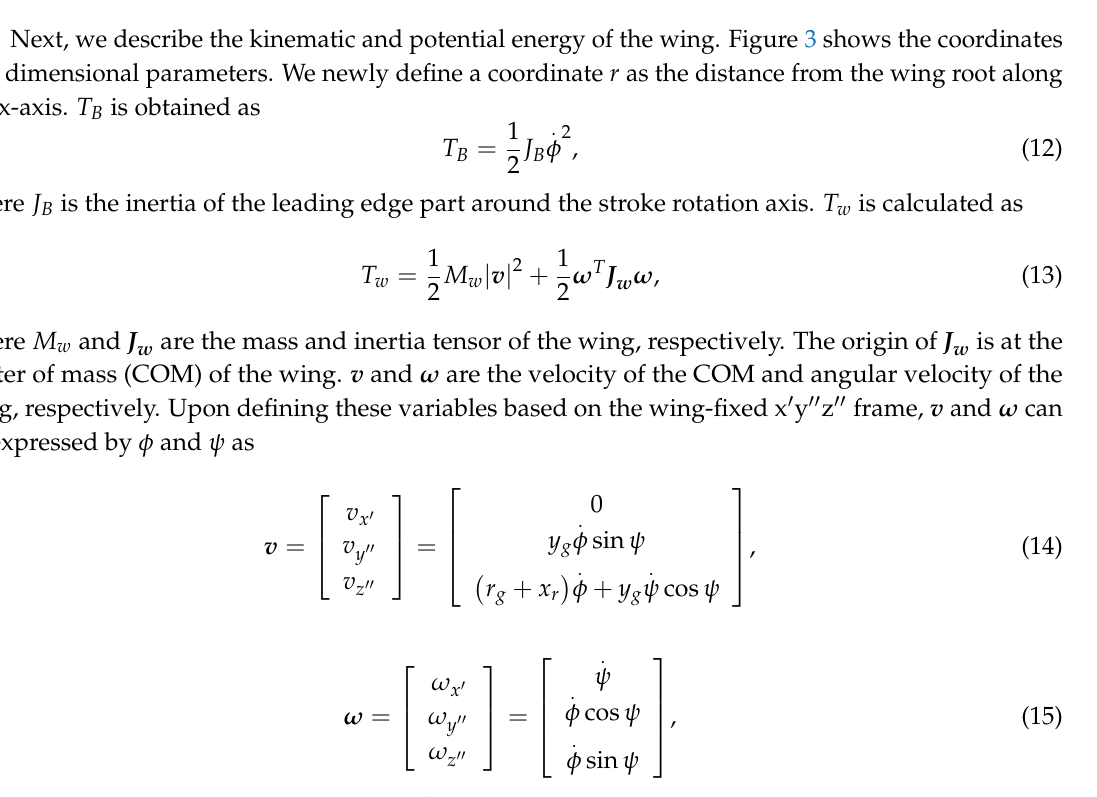
Figure 2. Coordinate systems and dimensions of unimorph actuator and wing.